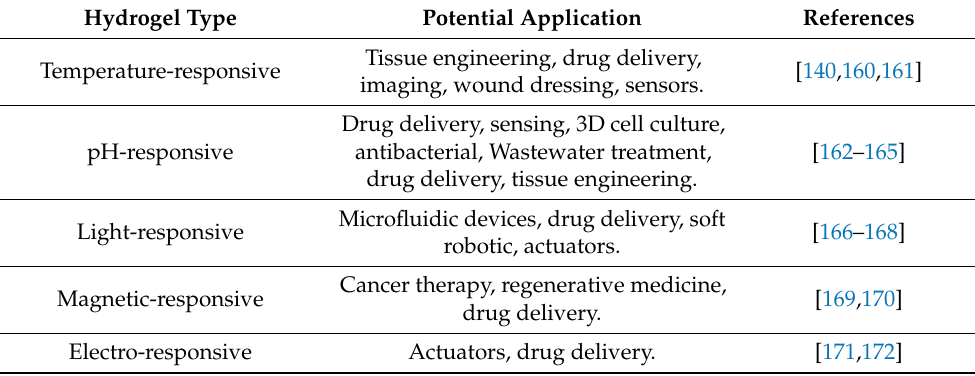
Table 1. Overview of potential applications of smart hydrogels based on their